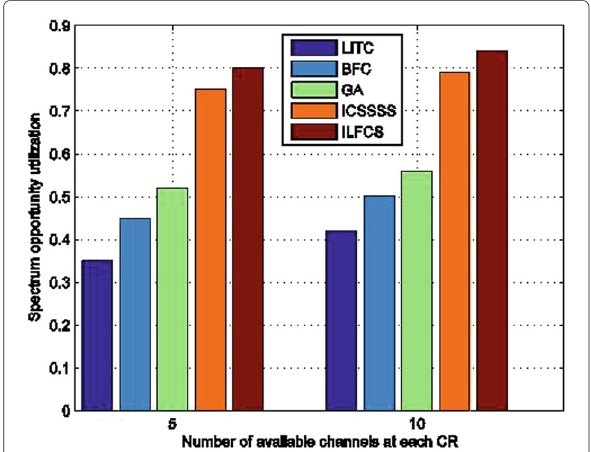
Fig. 21 Spectrum opportunity utilization for LITC, BFC, GA, ICSSSS, and ILFCS in case of long-term PU activity. The results of different simulation experiments to measure Spectrum opportunity utilization for LITC, BFC, GA, ICSSSS, and ILFCS in case of long-term PU activity are shown